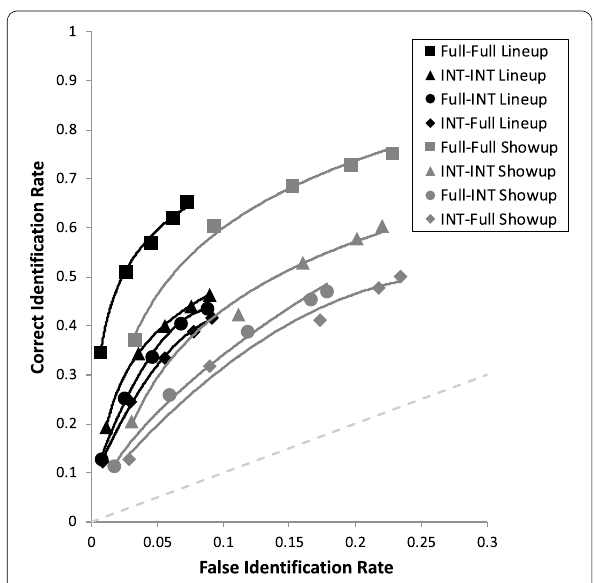
Fig. 9 ROC curve for each condition represented in Table 2